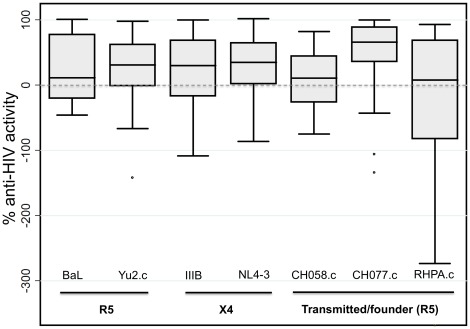
Broad and highly variable anti-HIV-1 activity of cervicovaginal lavage fluid from 57 HIV-infected women against multiple R5 and X4 strains of HIV-1, including transmitted/founder viruses.Bars depict median, interquartile range and 95% confidence intervals. Negative values indicate enhancement of infection.